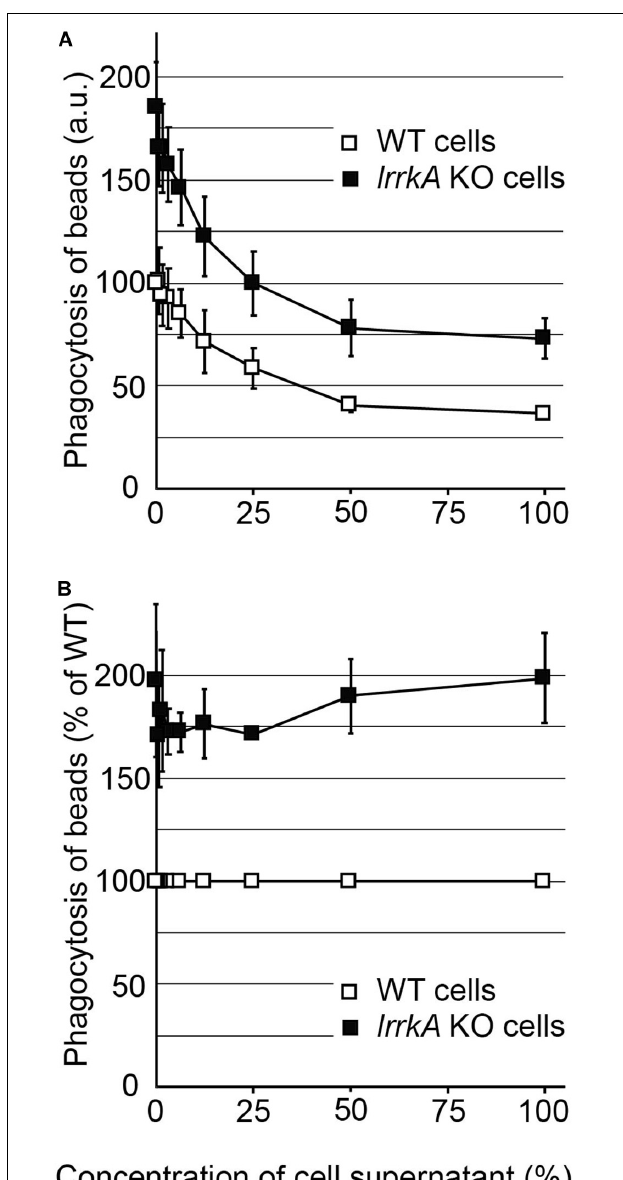
FIGURE 3 | Response of lrrkA KO cells to secreted quorum-sensing factors. (A) WT or lrrkA KO cells were incubated for 4 h with a cellular supernatant of WT cells diluted in fresh medium as indicated. The ability of the cells to ingest polystyrene beads was then measured as described in the legend to Figure 1 . At all concentrations of quorum-sensing factors, lrrkA KO cells phagocytosed beads more efficiently than WT cells (average ± SEM, N = 3 independent experiments). (B) For each condition, phagocytosis by lrrkA KO cells was represented as a percentage of WT phagocytosis in the same condition. In all conditions, lrrkA KO cells phagocytosed 1.5–2 times more beads than WT